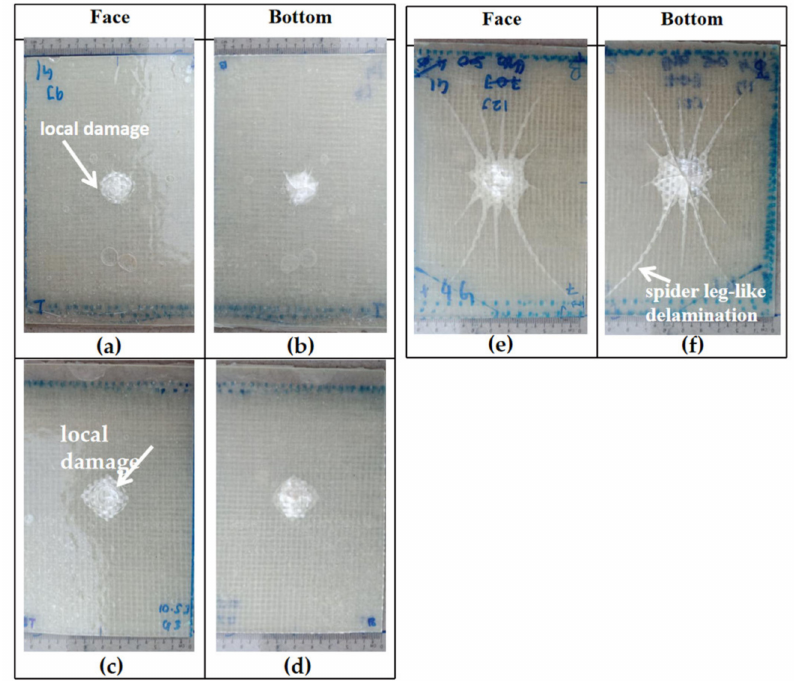
Figure 17. Visual damage of impacted GGGG: ( a ) GGGG 9.0 J, ( b ) GGGG 9.0 J, ( c ) GGGG 10.5 J, ( d ) GGGG 10.5 J, ( e ) GGGG 12.0 J and ( f ) GGGG 12.0